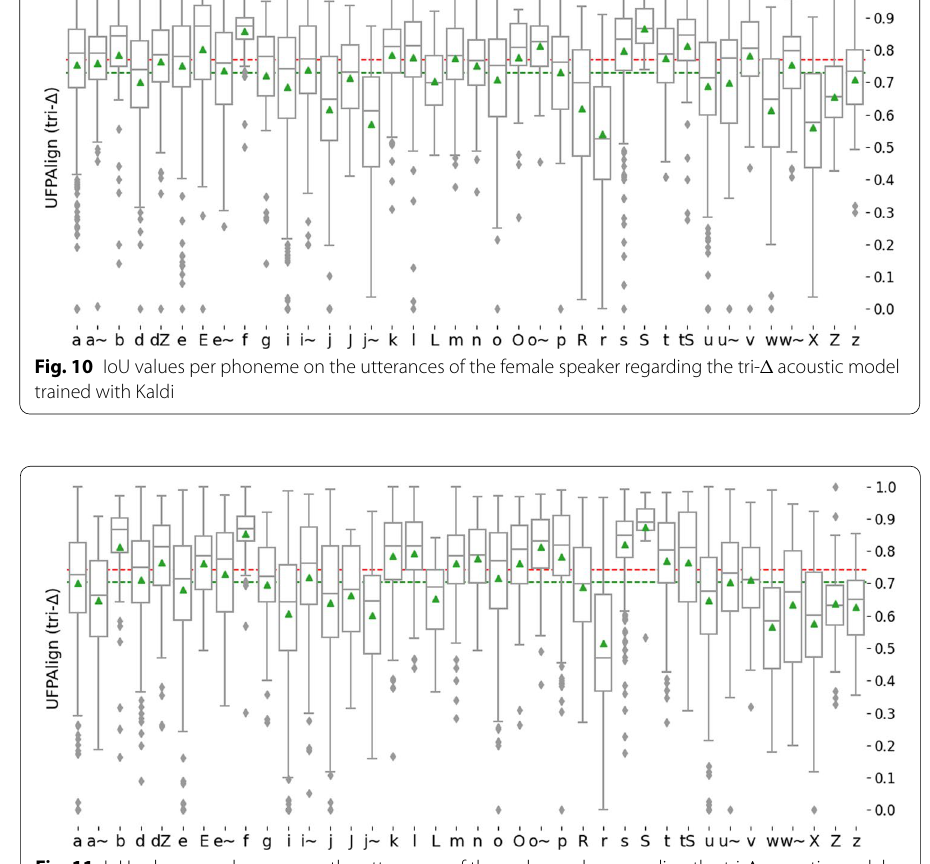
Fig. 11 IoU values per phoneme on the utterances of the male speaker regarding the tri- (cid:31) acoustic model trained with